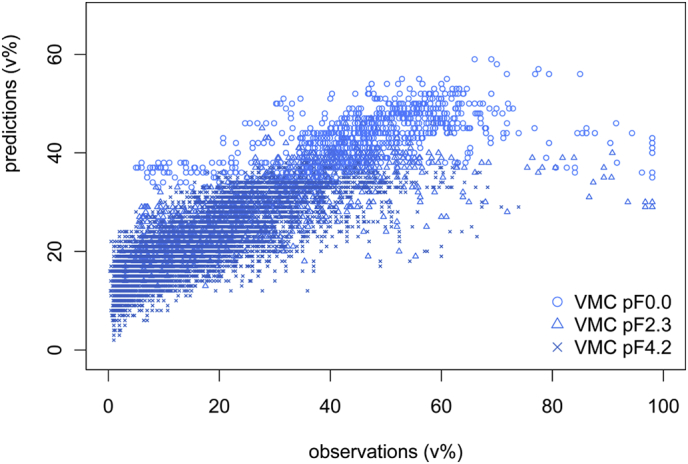
Predicted (mapped) versus observed VMC at saturation (pF 0), FC (pF 2.3) and PWP (pF 4.2).